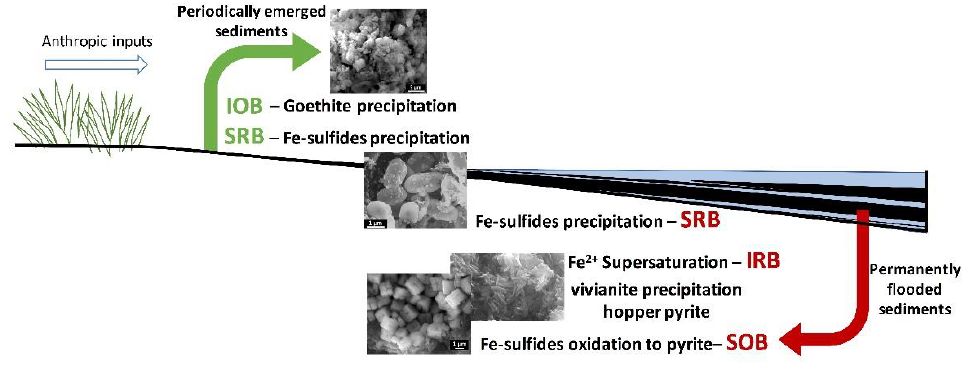
Figure 7. Bacterial groups and mineral precipitation in the organic-matter-rich sediments from La Playa dam. SRB: sulfate-reducing bacteria; IRB: iron-reducing bacteria; SOB: sulfur-oxidizing bacteria; IOB: iron-oxidizing bacteria.